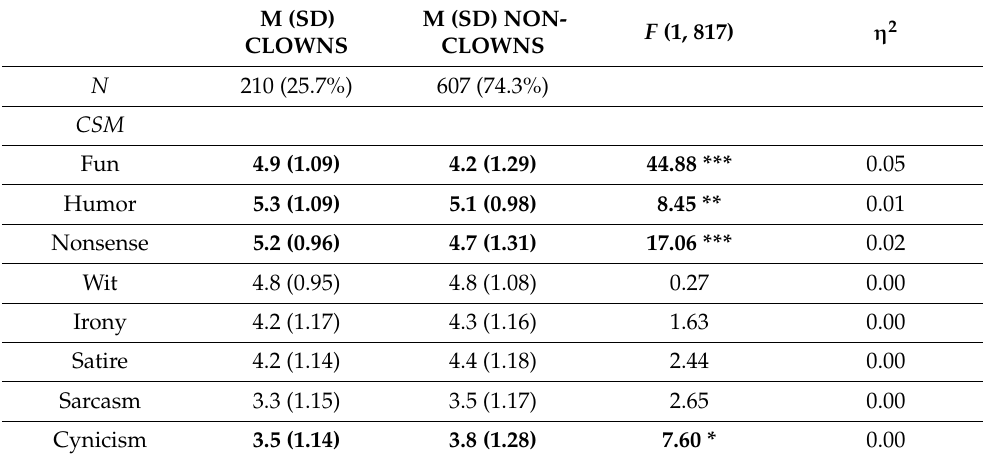
Table 2. Mean scores (and standard deviations in parentheses) of Clowns and Non-clowns and CSM.